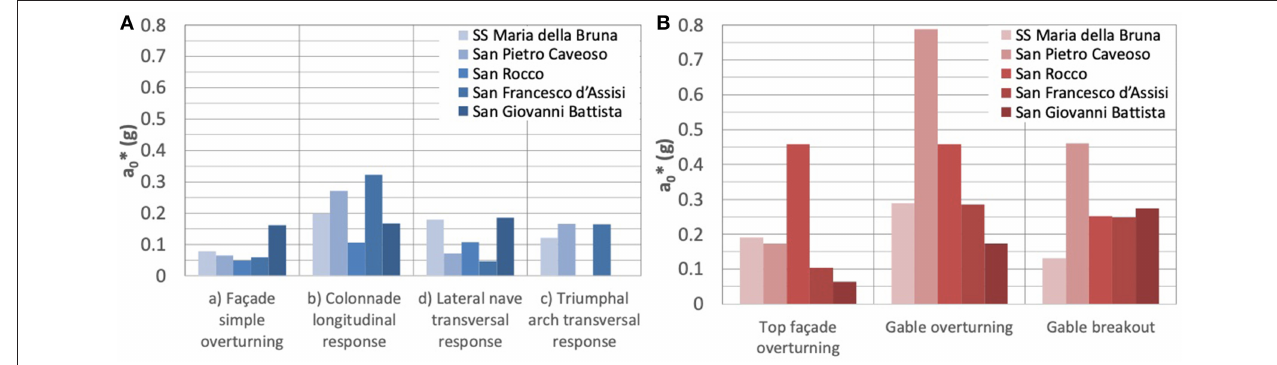
FIGURE 5 | Spectral accelerations a * 0 corresponding to the activation of a response mechanism (A) directly and (B) not directly ground-connected according to the LV2 method.